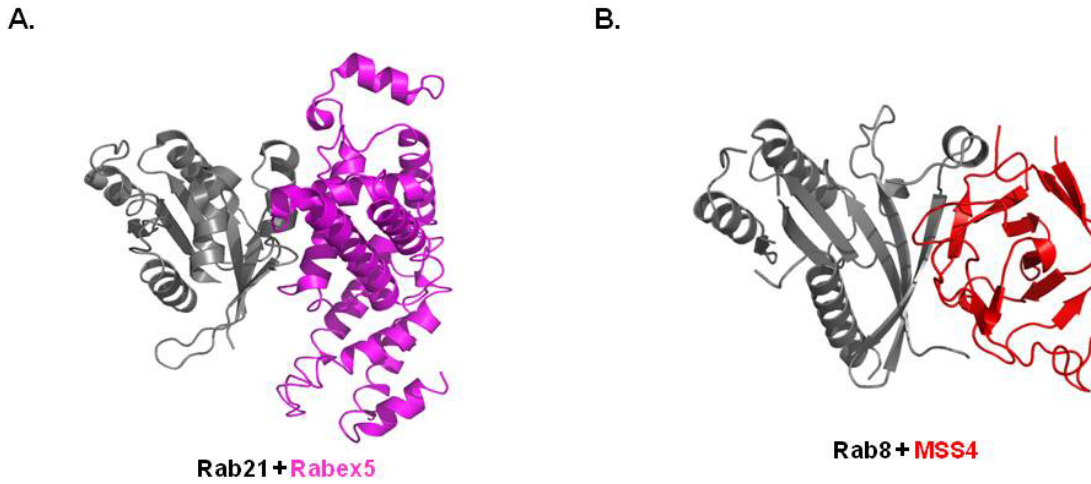
Figure 3. ( A ) Crystal structure of Rab21/Rabex5 complex (PDB ID: 2OT3)—The representative Rab/GEP complex structure; ( B ) Crystal structure of Rab8/MSS4 complex (PDB ID: 2FU5)—The representative Rab/GEP complex